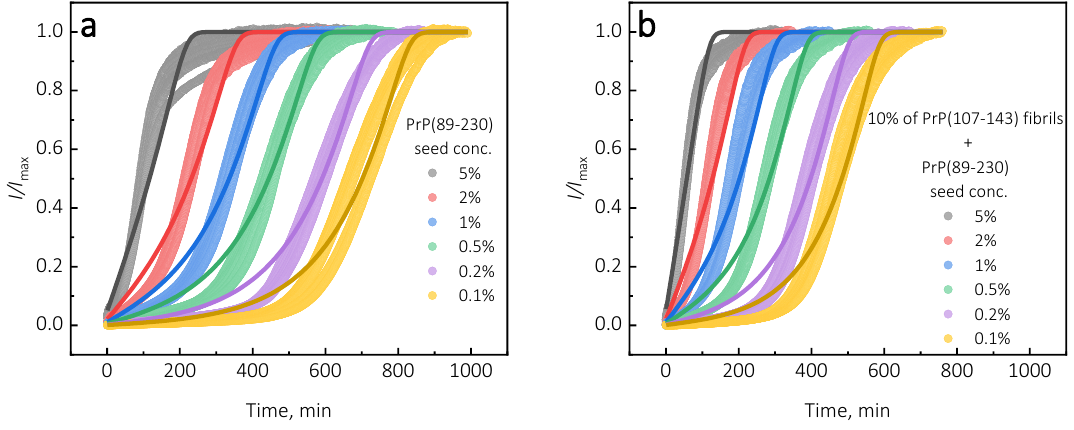
Figure A9. Kinetics of PrP(89-230)-seed-induced aggregation reaction performed in the absence ( a ) or presence ( b ) of PrP(107-143) fibrils. Continuous lines denote the fit obtained by fitting “Saturated Elongation and Secondary Nucleation” model to the experimental data using the AmyloFit software